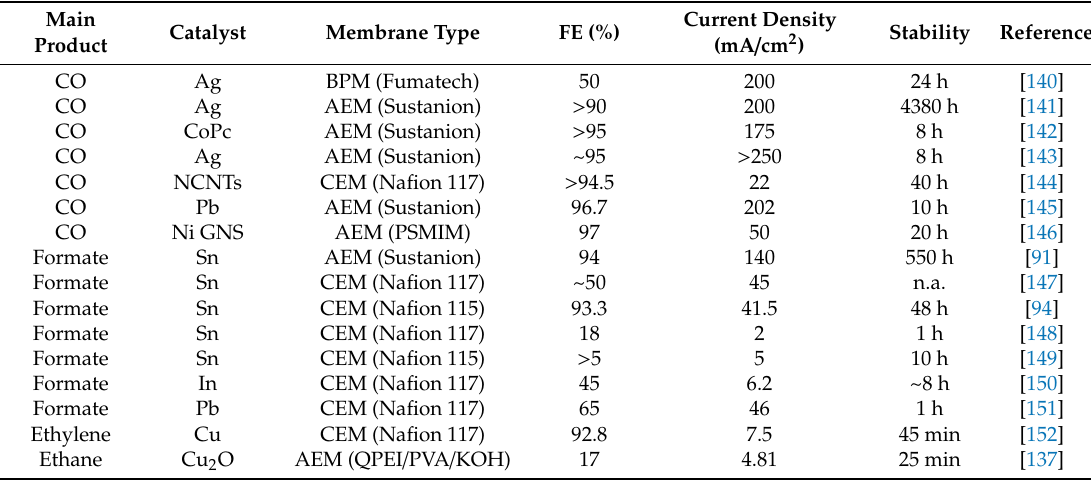
Table 2. A list of CO 2 conversion performance using PEM electrolysers. AEM: anion-exchange membrane, CEM: cation-exchange membrane, BPM: bipolar membrane, ~: